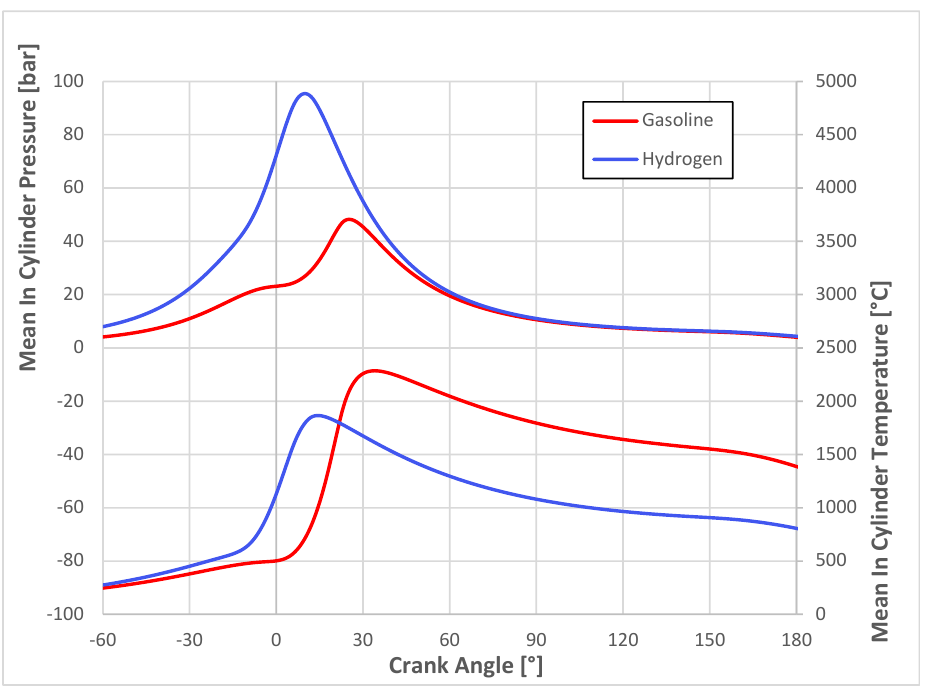
Figure 8. Comparison between in-cylinder data for the engine fueled with hydrogen and gasoline at the same operating point. Engine speed 3000 rpm. Engine torque 120 Nm.